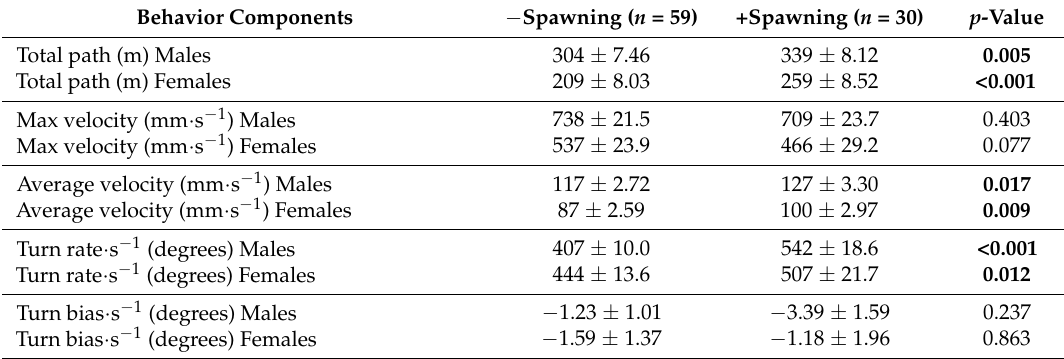
Table 1. Differences in behavior in spawning and non-spawning control zebrafish